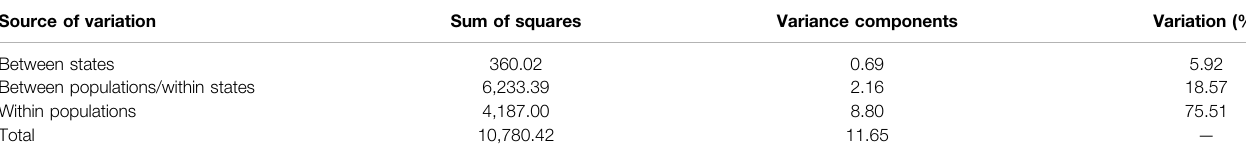
TABLE 9 | Results of the analysis of molecular variance for populations of Curraleiro Pé-Duro from three Brazilian states based on microsatellite data. Source of variation Sum of squares Between states